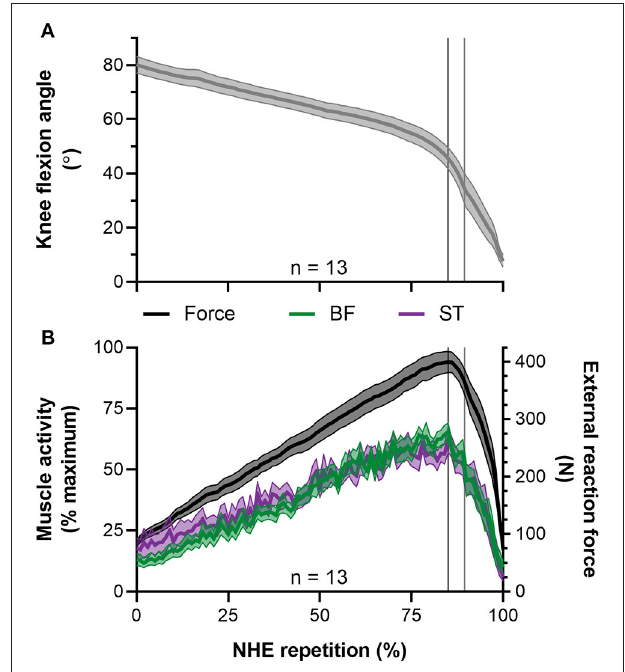
FIGURE 8 | Mean ± SEM left-sided (A) knee flexion angles and (B) normalized biceps femoris (BF) and semitendinosus (ST) EMG root-mean-square amplitudes (left y-axis) and external reaction forces (right y-axis) during the Nordic hamstring exercise (NHE). Due to the different durations that participants performed the NHE, all data from the NHE trial with the highest peak force across participants were clipped between 10% of peak NHE force before and after peak force, time normalized to 100 data points, and then averaged. The vertical black lines indicate when peak NHE force and peak muscle activities occurred. The vertical gray lines indicate when peak knee extension velocity